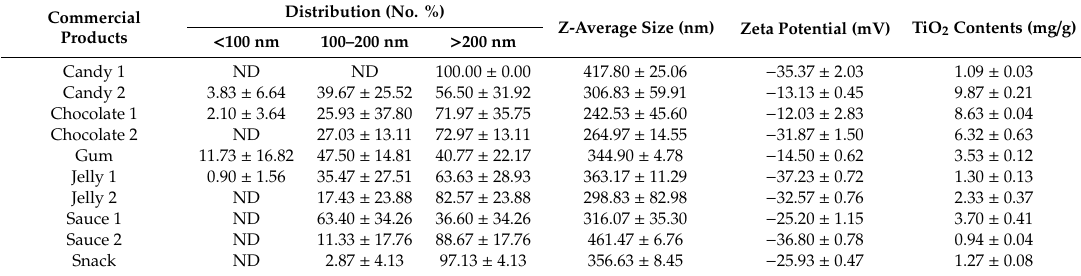
Table 5. Size distributions, hydrodynamic radii, zeta potentials, and quantitative results of TiO 2 recovered from commercial